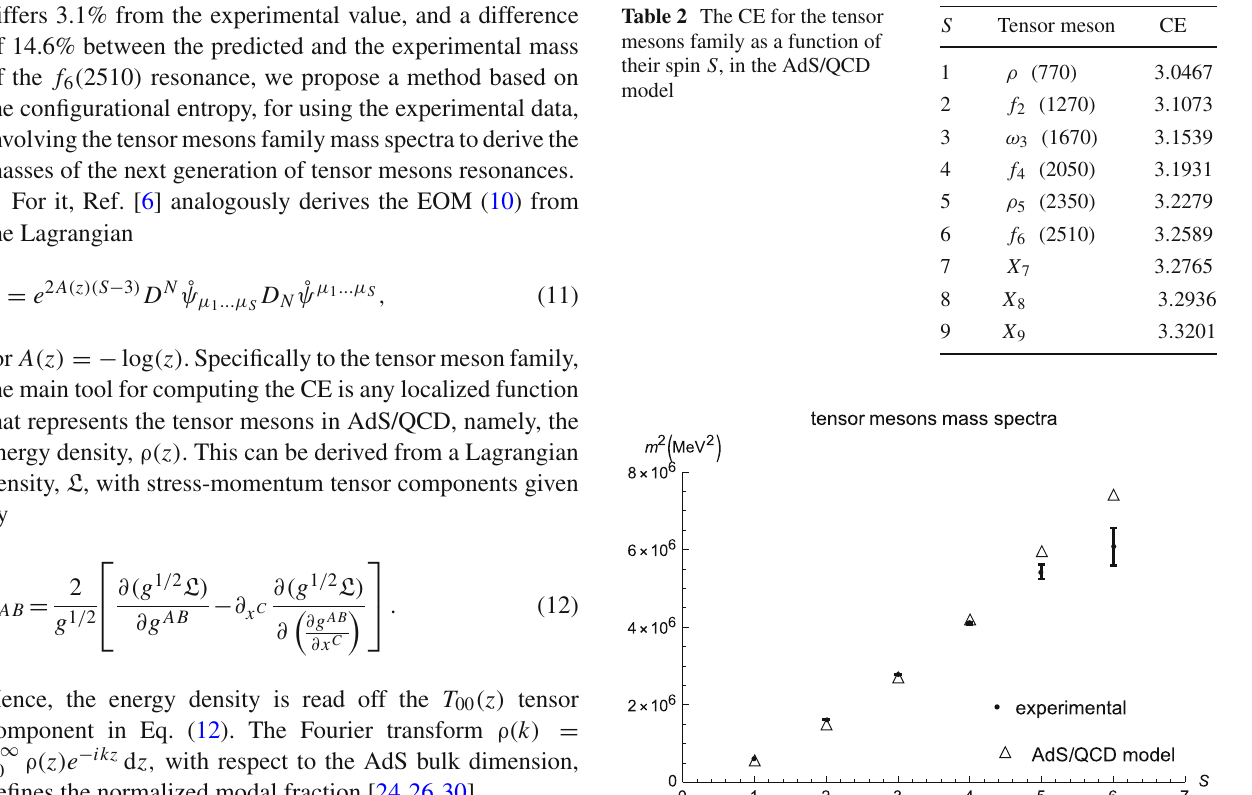
Fig. 1 Mass spectra of the ρ( 770 ) , f 2 ( 1270 ) , ω 3 ( 1670 ) , f 4 ( 2050 ) , ρ